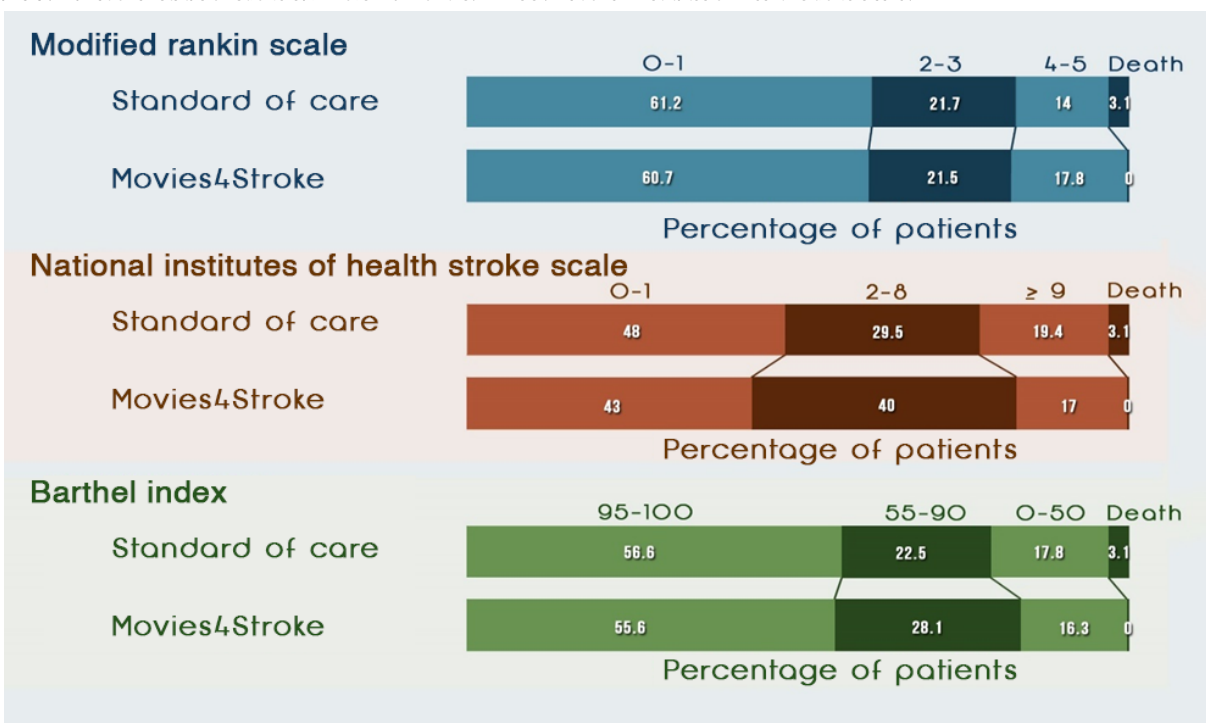
Figure 5. Functional status of stroke survivors—6 months. NIHSS: National Institutes of Health Stroke